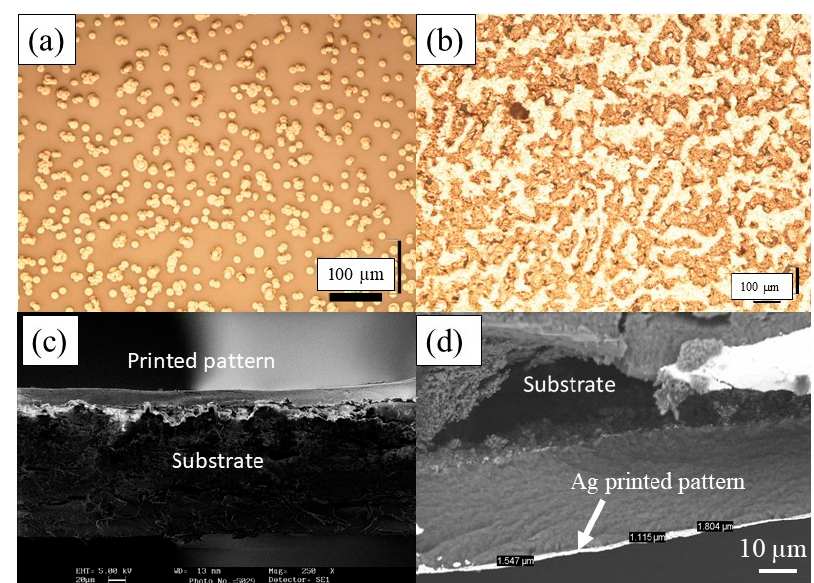
Figure 5. Optical micrograph of the inkjet printed Ag pattern after ( a ) 1 pass and ( b ) 10 passes. ( c ) SEM image of 10 passes. ( d ) SEM cross-sectional image of the Ag printed pattern after 5 passes.